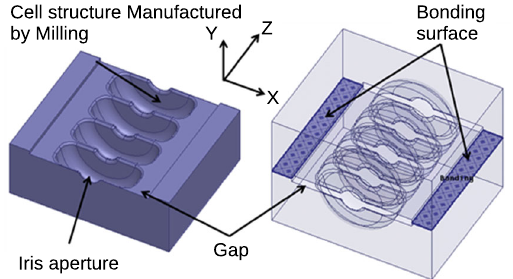
1. The HFSS design of the structure demonstrating the structure half on the left and how each half will be